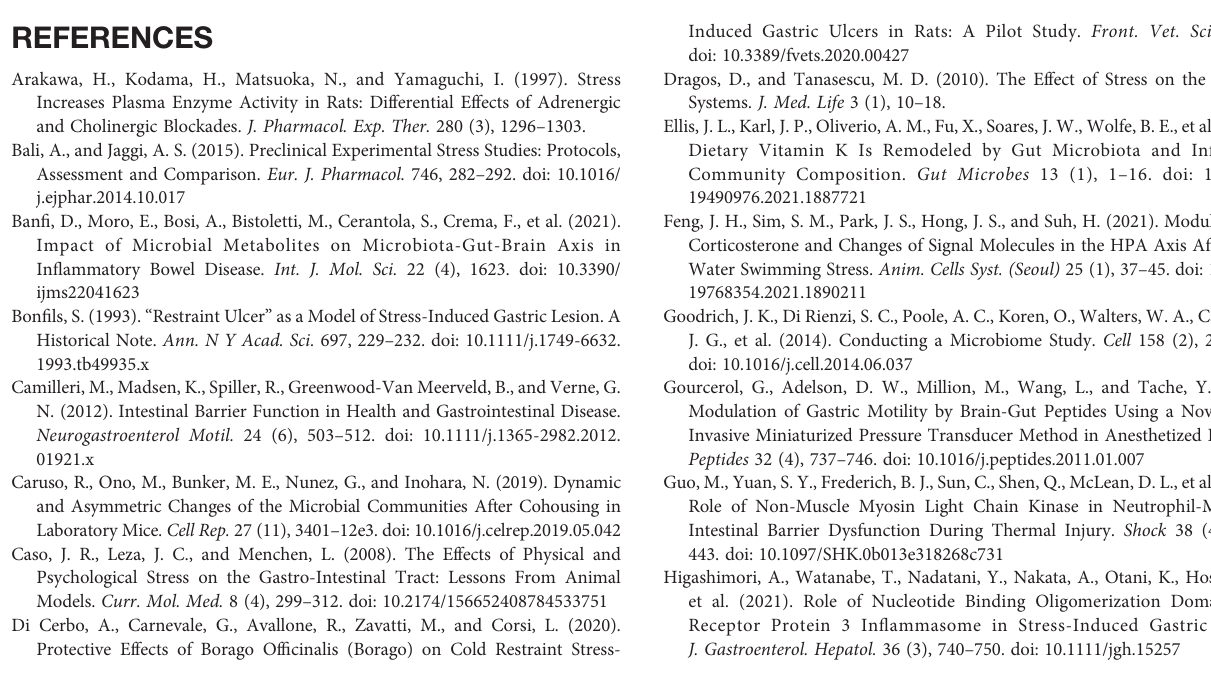
Supplementary Figure 1 | (A) Representative anti-CD4 immunohistochemistry photomicrographs of duodenum. CD4-speci fi c antibodies were detected with Cy3- conjugated secondary antibodies (red), Nuclei were counterstained with DAPI. 1 h CWIR treatment may notasuf fi cient time to observe signi fi cant T cellin fi ltration, only erythrocytes showed unspeci fi c staining (white arrowhead). Scale bar = 150 m m, n= 3per group. (B) Representative western blotimage and proteinquanti fi cation